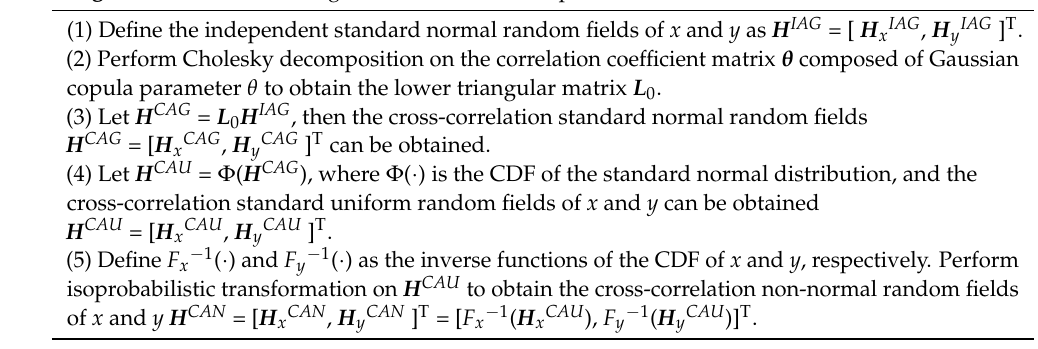
Algorithm 2 Simulation algorithm of Gaussian copula-based CCRF